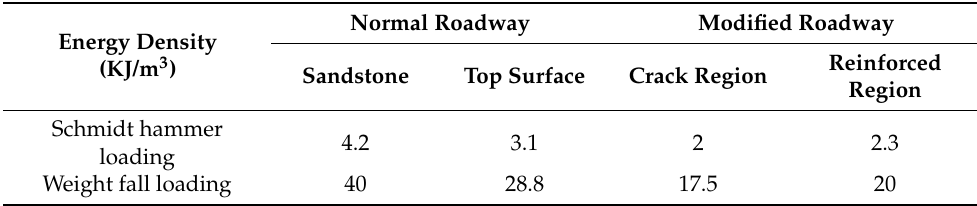
Table 6. Energy density along the propagation path of impact load by a Schmidt hammer and a falling weight above the normal roadway and modified